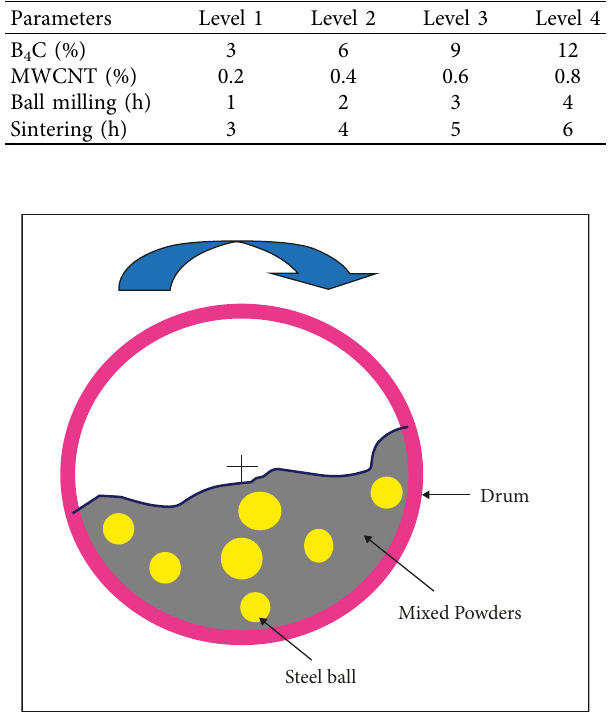
Figure 1: Ball milling